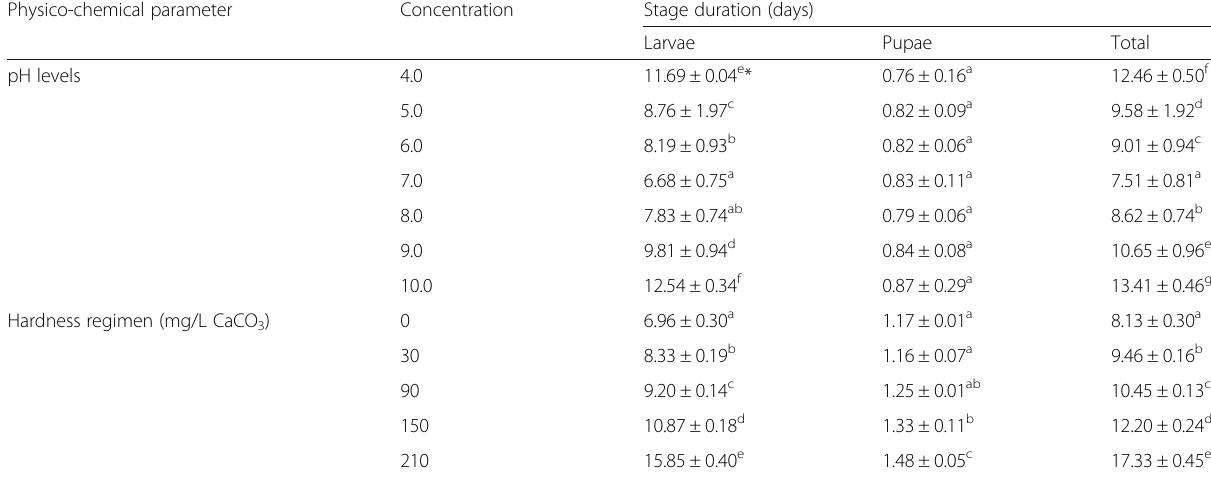
Table 1 Effects of water pH and hardness levels on the duration of the development and growth rate of Culex quinquefasciatus Physico-chemical